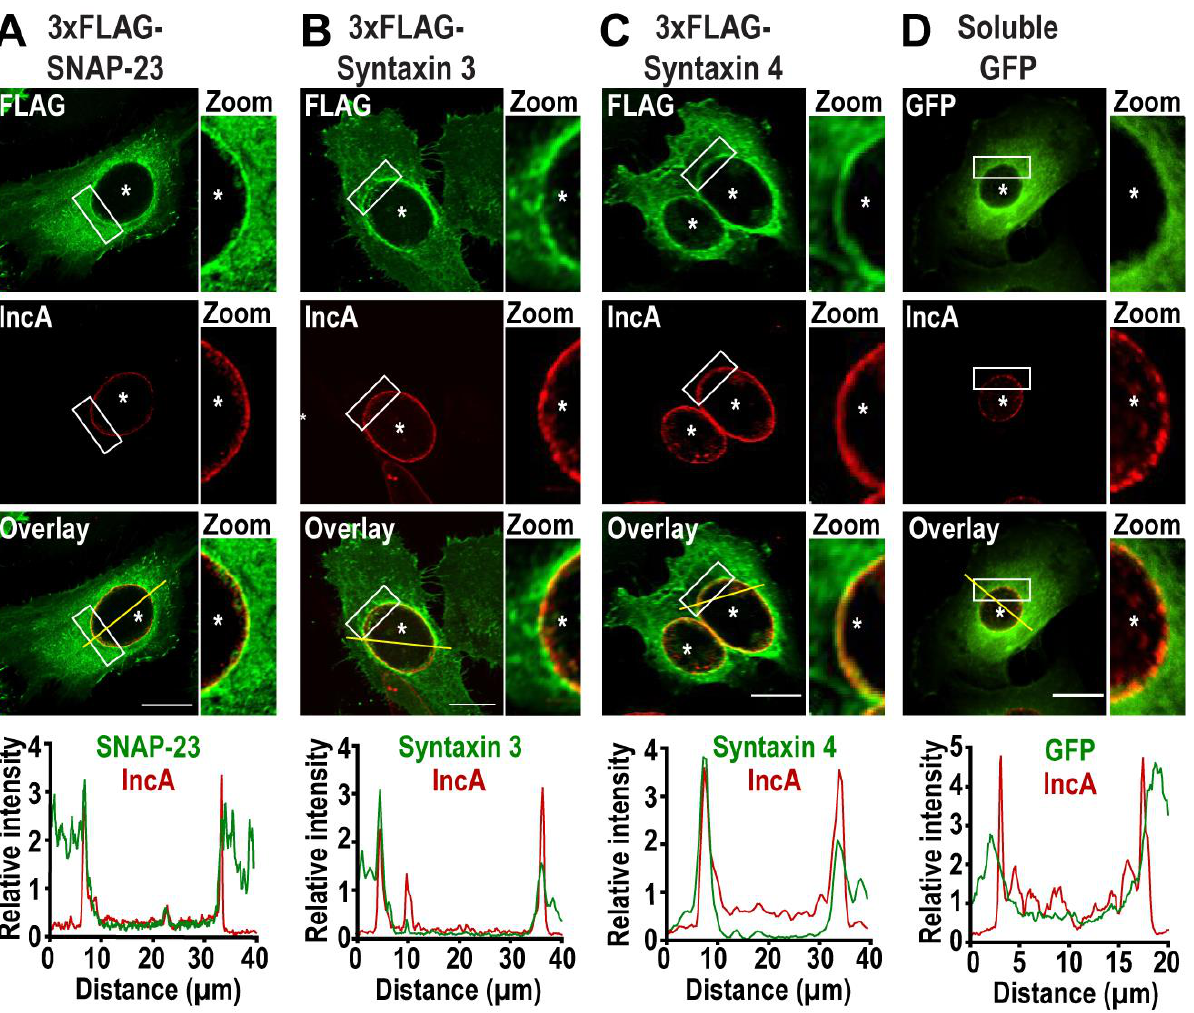
FIGURE 1: SNAP-23, Syntaxin 3, and Syntaxin 4 are recruited to the chlamydial inclusion. HeLa cells were infected with C. trachomatis at a MOI of 2 prior to being transfected with cDNA encoding (A) 3xFLAG-SNAP-23, (B) 3xFLAG-Syntaxin 3, (C) 3xFLAG-Syntaxin 4 or (D) GFP. At 24 h pi, the cells were fixed and labeled with anti-FLAG antibody (green) to label each SNARE and anti-IncA antibody (red) to identify the inclu- sion membrane. GFP-transfected cells (green) were only labeled with anti-IncA antibody (red). The boxed area of the inclusion membrane within each image is magnified to the right of each image (zoom). Asterisks denote inclusions. Scale bar = 20 μ m. Line intensity scans (graphs) were conducted using ImageJ to determine if the FLAG or GFP signal was co-incident with IncA. Yellow line in the overlay image indicates the region of the line scan. Concomitant green (3xFLAG-SNARE or GFP) and red (IncA) peaks signify localization on the inclusion